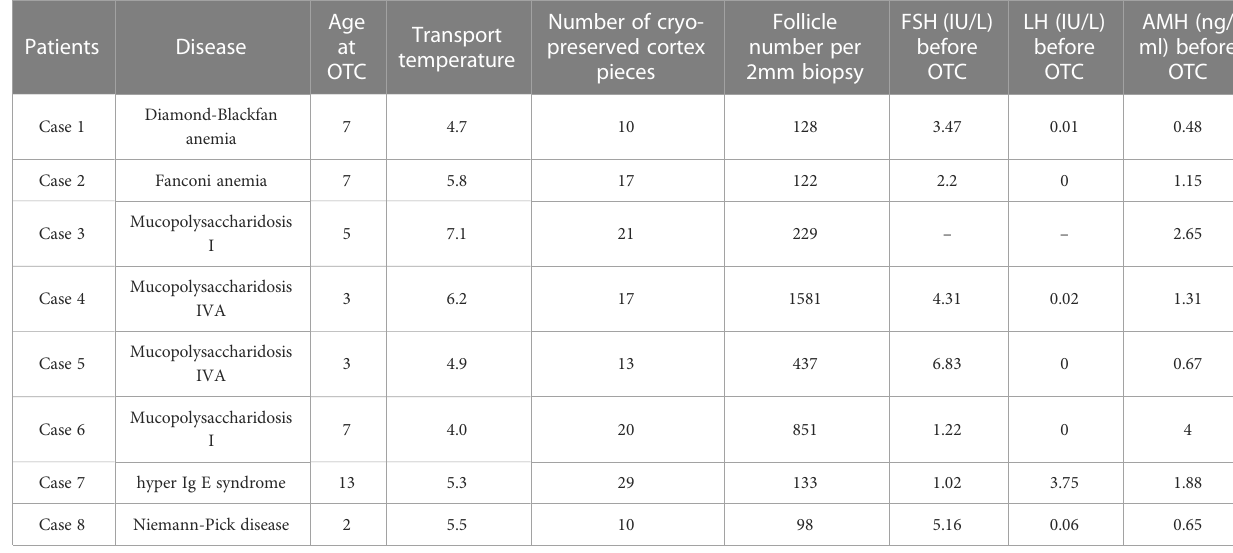
TABLE 1 Patient Characteristics before